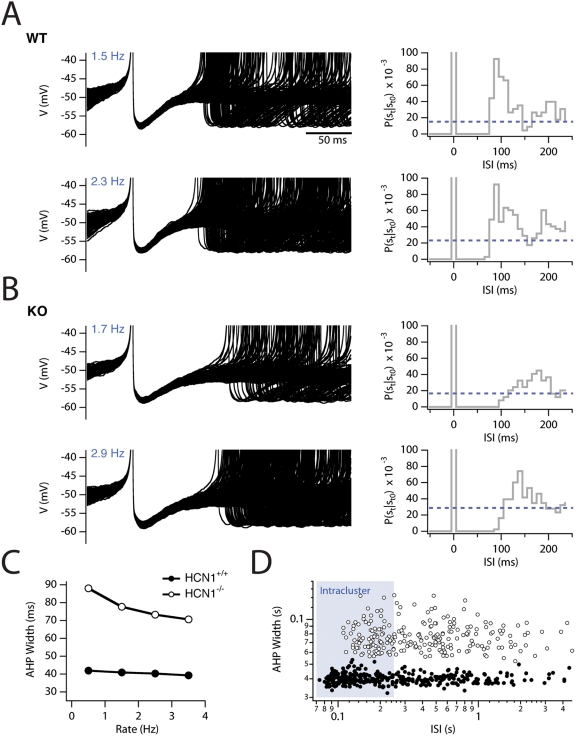
Recovery from the AHP is influenced by Ih and reflects
spike clustering.(A–B) Overlaid action potentials (left) and corresponding
conditional spike probabilities (right, truncated at
P = 0.1) from long simulations (150 s)
in which constant current was injected to the wild-type (A) and knockout
(B) models. Average firing rate from the selected trials is indicated in
blue. (C) Average width of the AHP at −52 mV for the wild-type
(closed circles) and knockout (open circles) spikes. (D) For a
representative trial (upper panels in A and B) a log-log plot of the AHP
width against the succeeding ISI for wild-type (closed circles) and HCN1
knockout (open circles) versions of the model.